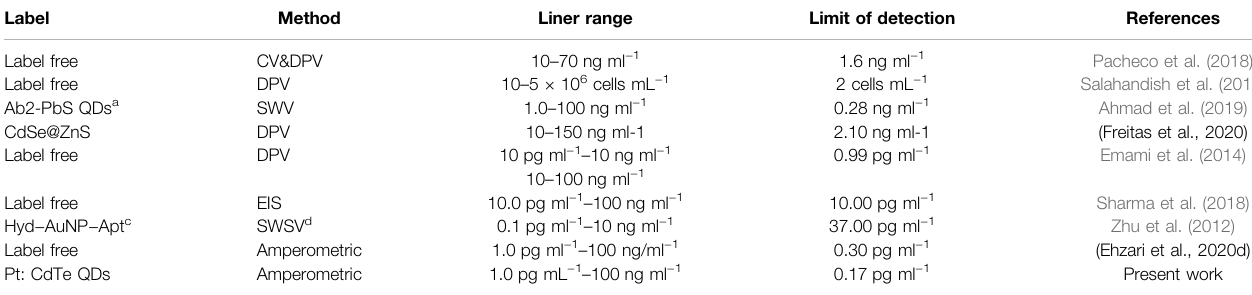
TABLE 1 | Comparison of different methods for HER2 detection. Label